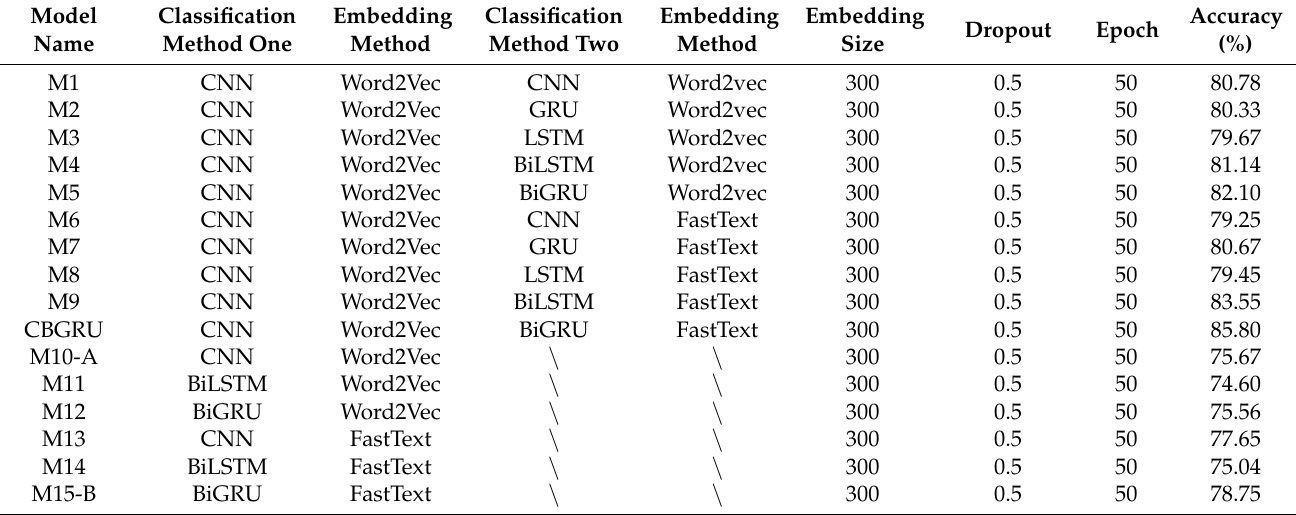
Table 2. Self-comparison